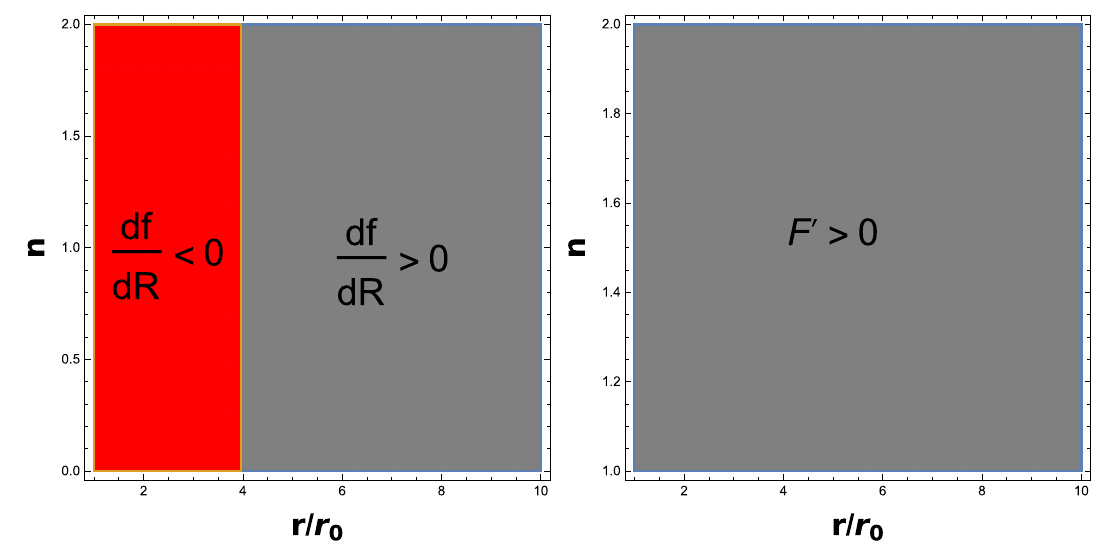
< 0 (left side) and gray region Fig. 1 Red Region shows that F = df dR shows F (cid:5) > 0 (right side), for shape function (cid:6)( r ) = ( r 0 ) n + 1 r − n with r 0 = 2 Km, α = 20 , β = − 0 . 1 and 0 ≤ n ≤ 2. So, we get